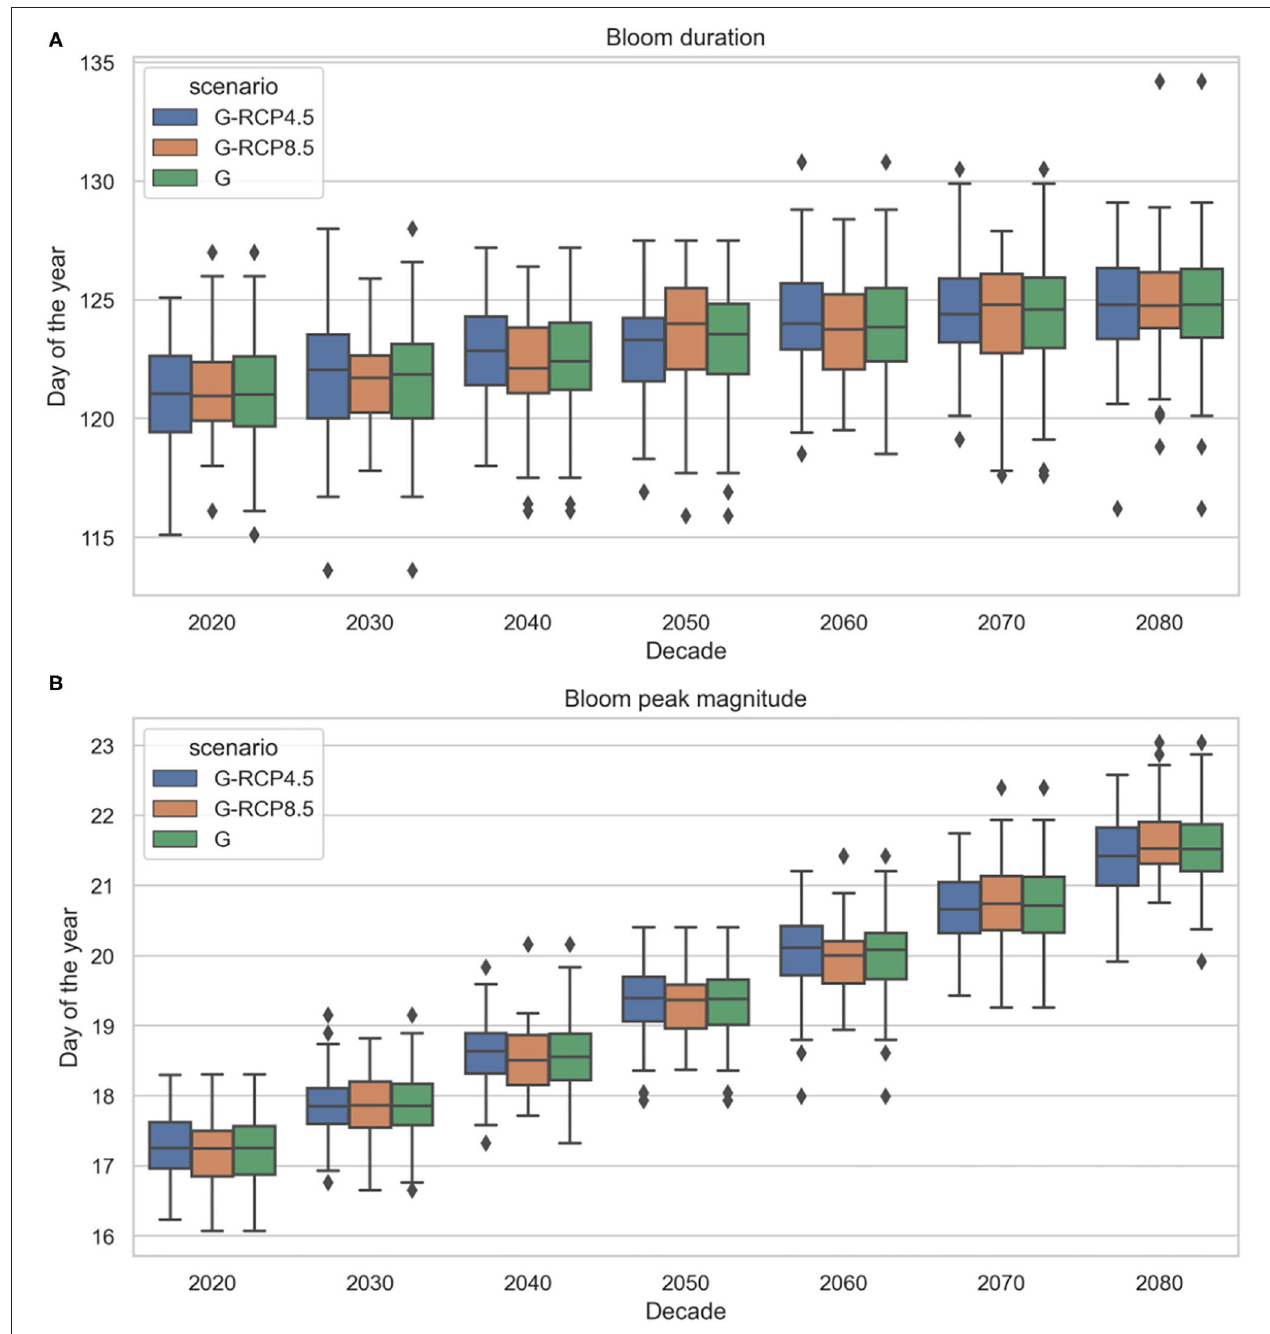
FIGURE 15 | Projected future phytoplankton spring bloom duration (A) and peak magnitude (B) under generated radiation and temperature projections (based EURO-CORDEX) (2019–2089).